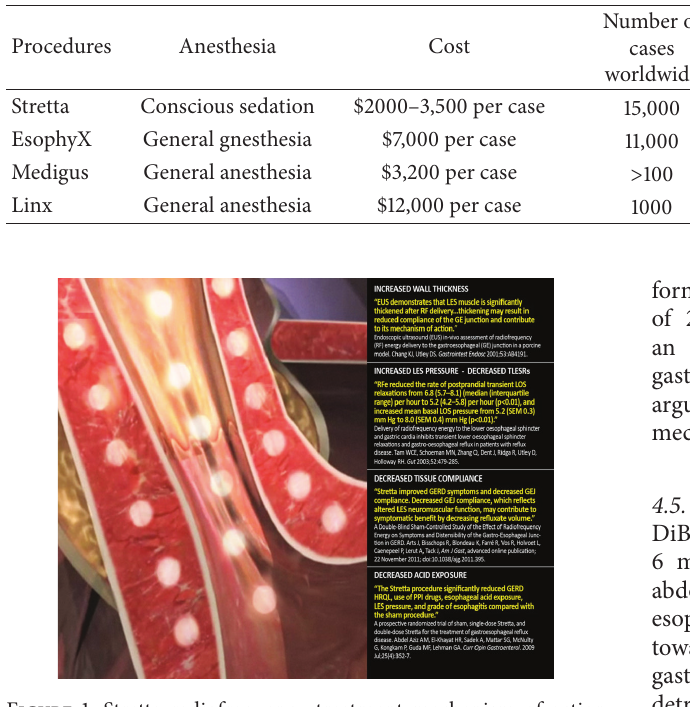
Table 1: Overview of treatments for GERD.